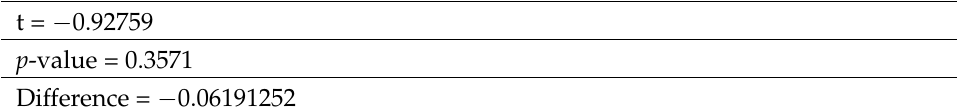
Table 6. Results of paired t -test applied to the data of Experiment 2 after correction.